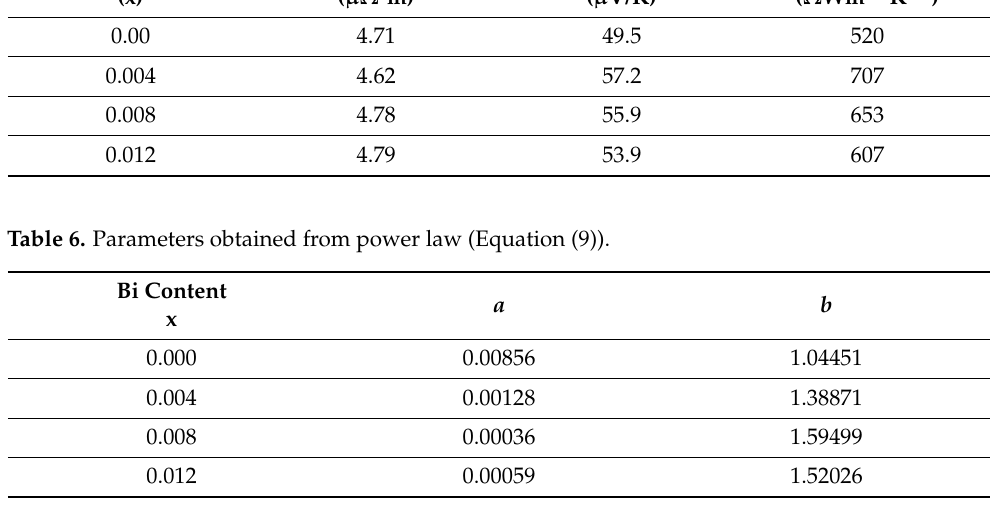
Table 5. Value of Resistivity, Seebeck coefficient, Power factor for Cu 2 − x Bi x Se (x = 0.00, 0.004, 0.008, 0.012) samples at 300 K.